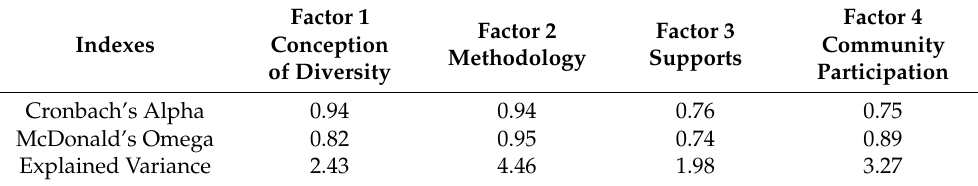
Table 6. Internal consistency of the CEFI-R